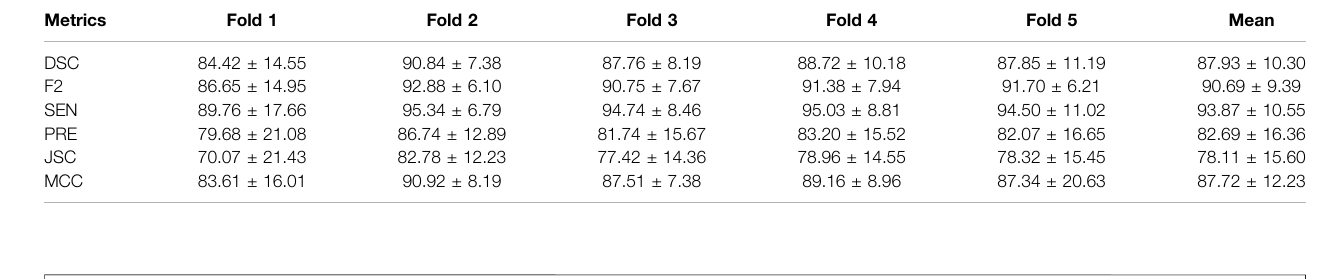
TABLE3| ComparisonofthefourROIsizesegmentationperformanceresults(%).